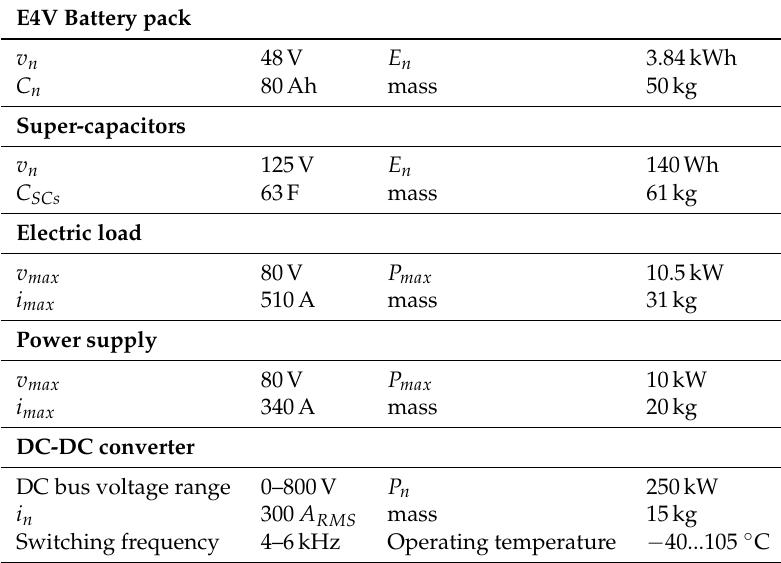
Table 1. Electric characteristics of the 10kW hybrid system.